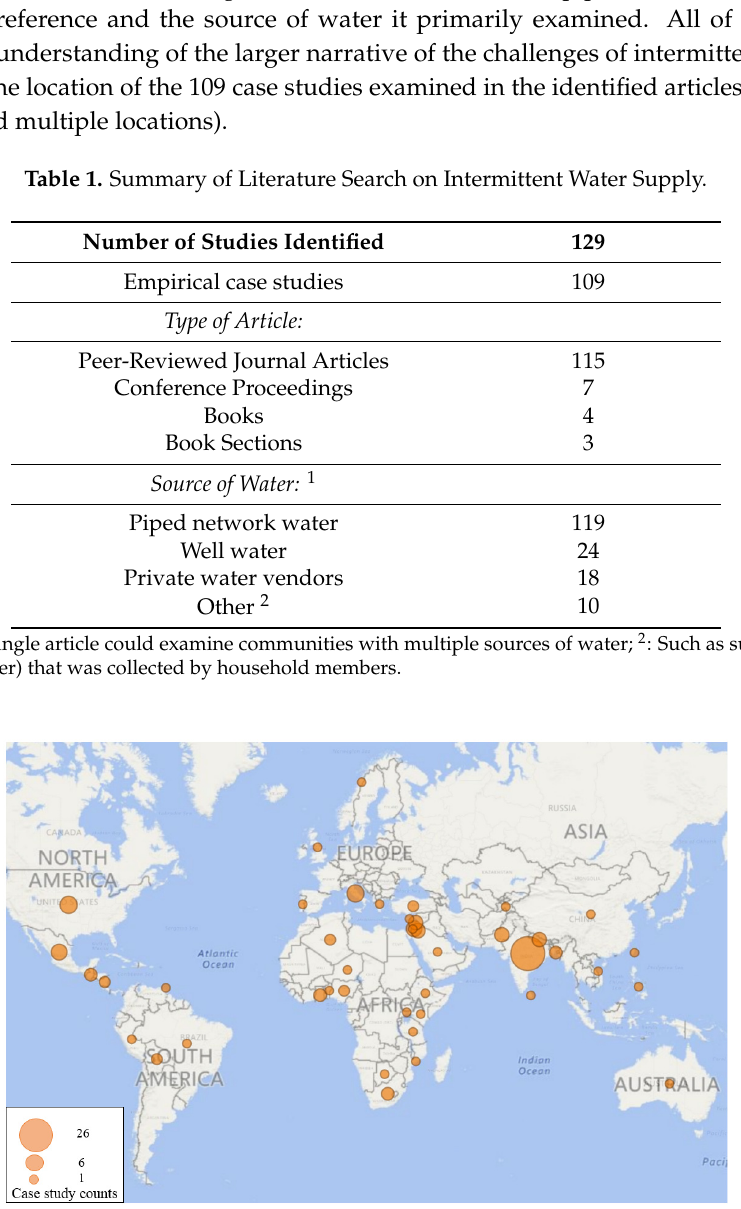
Figure 1. Geographic distribution of intermittent water case studies found in the literature [1–129].